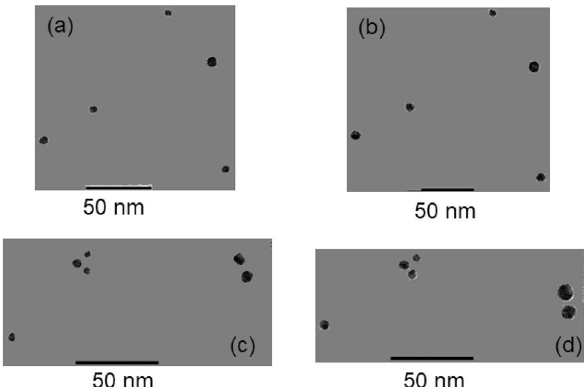
Figure 2. Representative TEM images ( a ) before and ( b ) after irradiation at 325 nm (9 mW for 90 s), and ( c ) before and ( d ) after irradiation at 808 nm (400 mW for 15